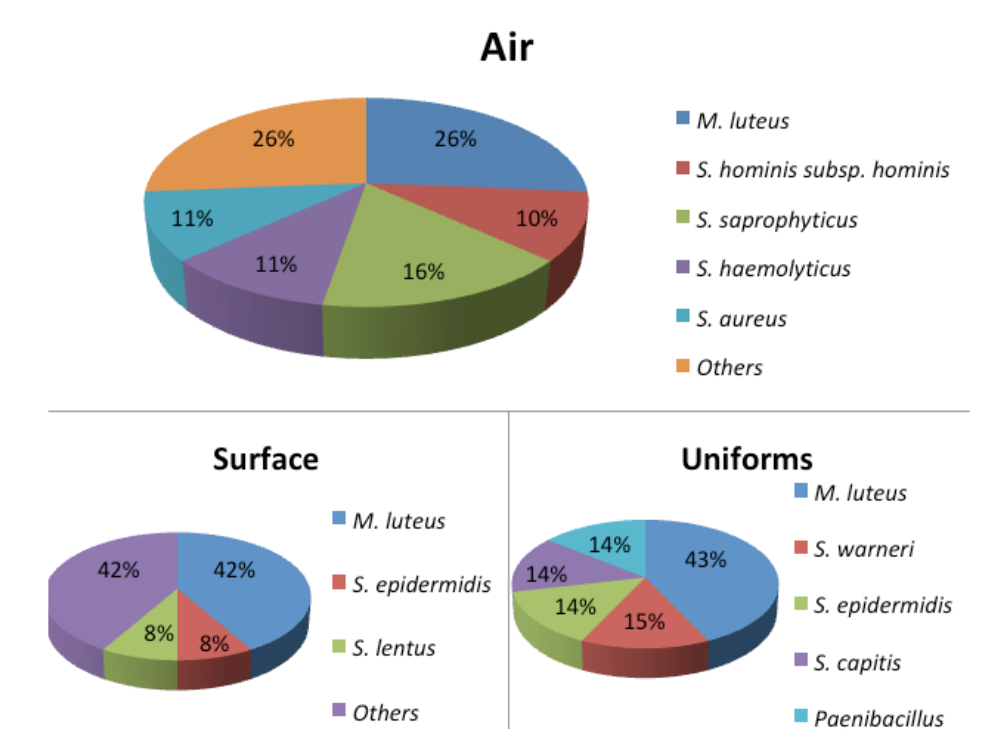
FIGURE 8 – Microorganisms identified in air, surface and uniforms samples of Material and sterilization center (MSC) – Hospital B.